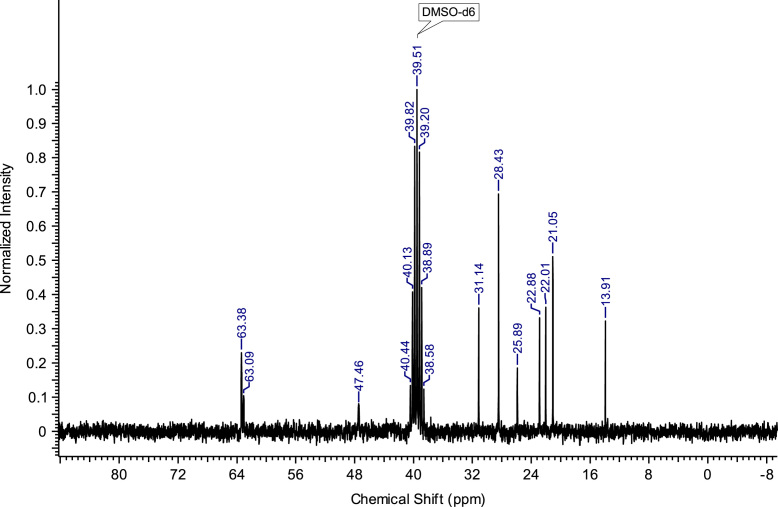
13C NMR spectra of C8(MPyrr)SbF6.